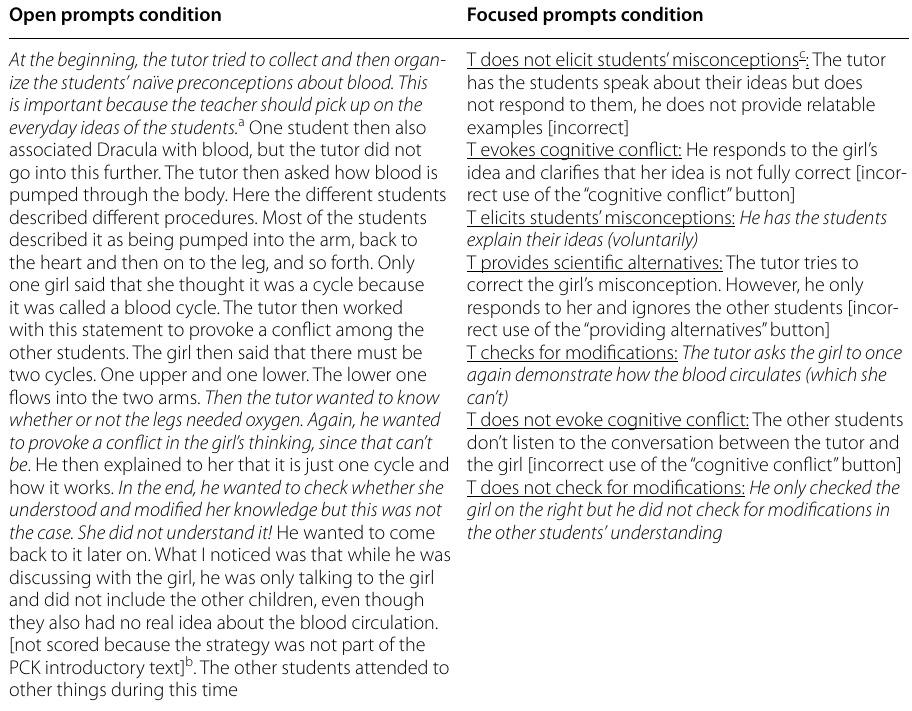
Table 2 Training phase example comments for the different self-explanation prompts